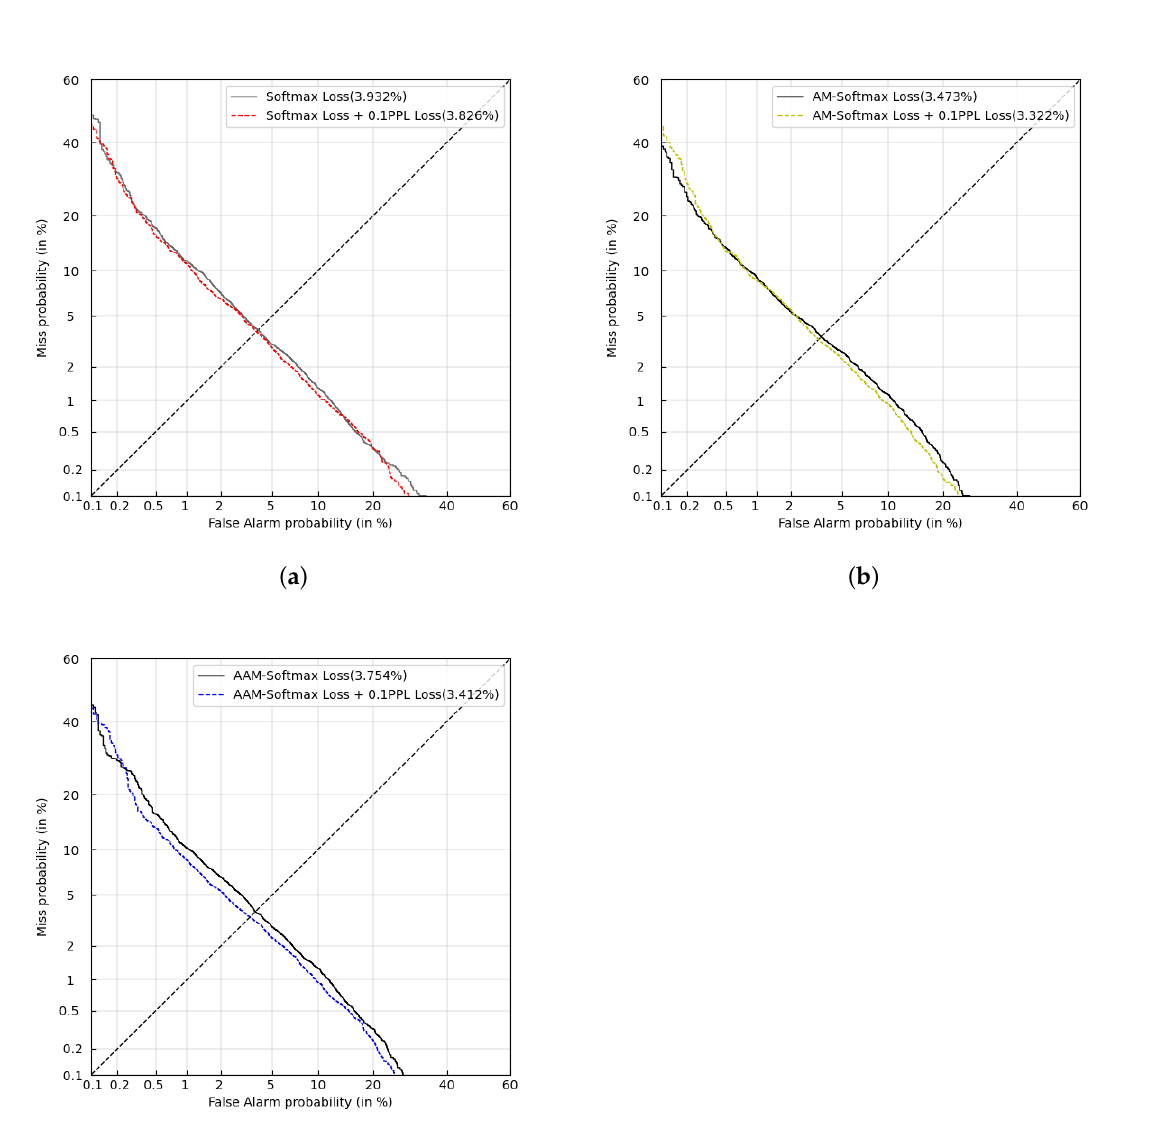
Figure 4. DET curve for VoxCeleb test results of add PPL loss to different loss functions. ( a ) CE & CE + PPL; ( b ) AM & AM + PPL; ( c ) AAM & AAM + PPL.